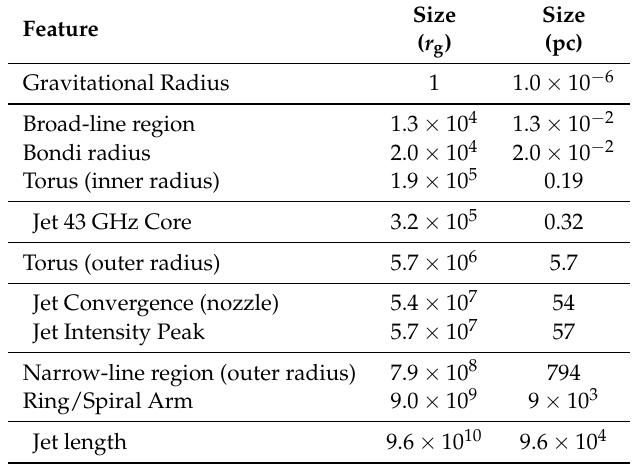
Table 3. Map of the narrow-line Seyfert 1 Galaxy J0324 + 3410. See Figure 2 for a